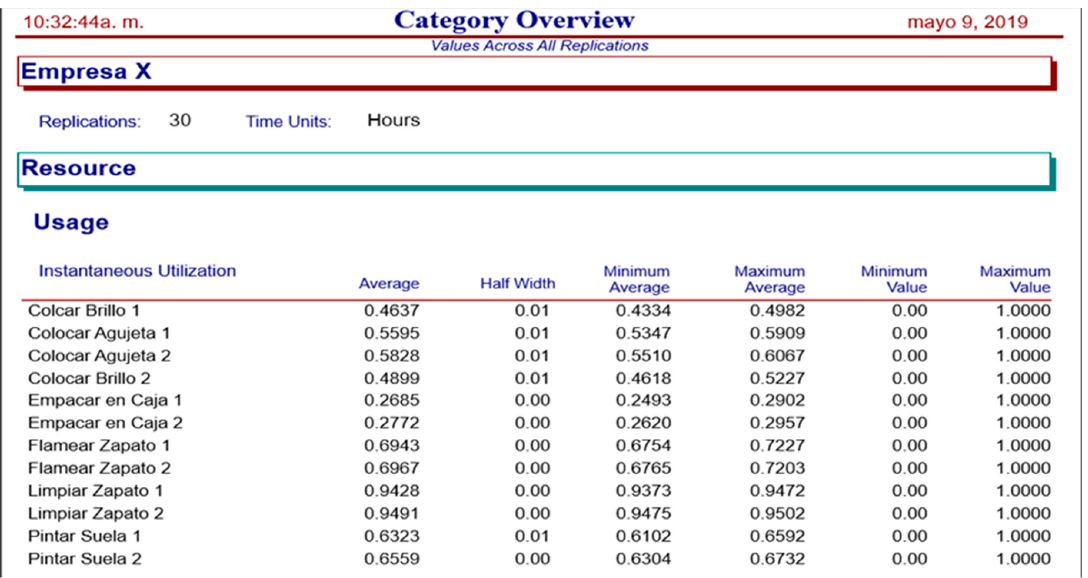
Figure A3 . Utilization per activity. Current process.